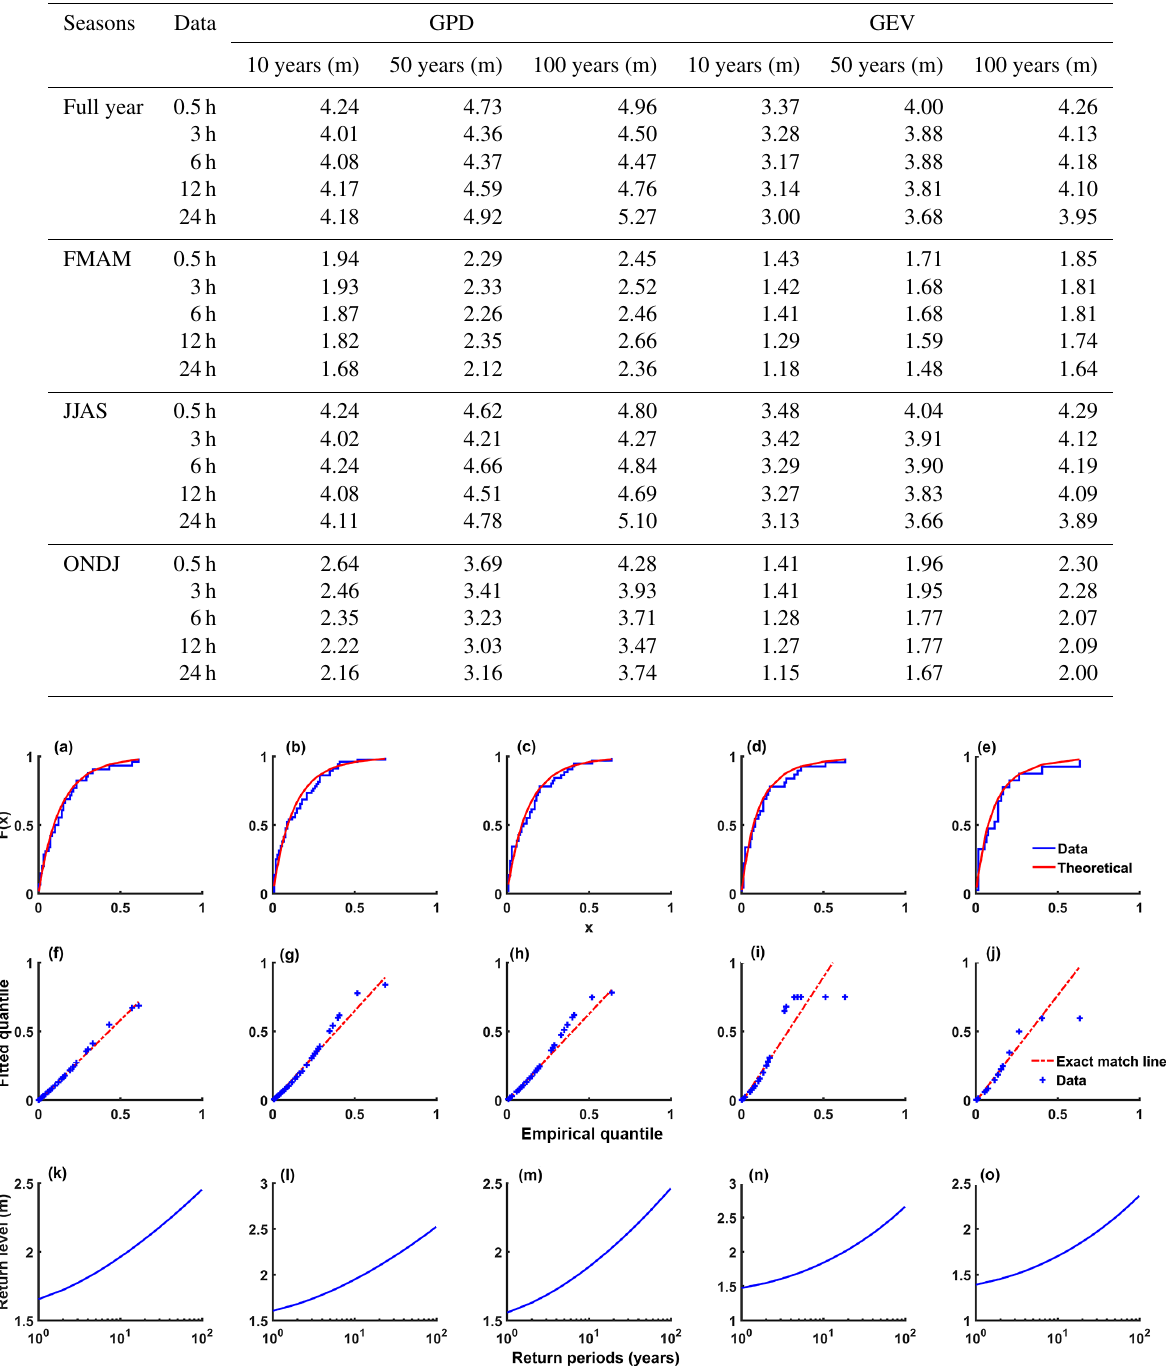
that of Anoop et al. (2015) reported that average H s attains its peak at around 3 m during JJAS and that the FMAM sea- son is relatively calm (0.5–1.5 m) compared to ONDJ (1.5–